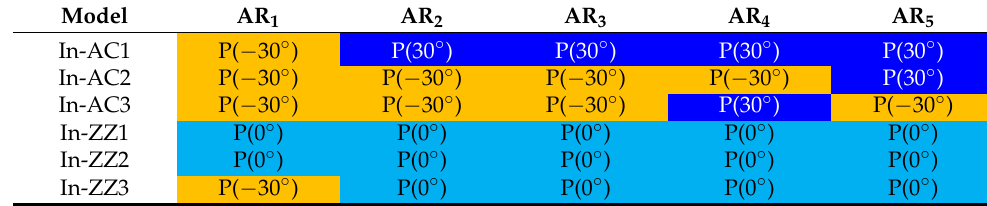
Note that the same crack paths share the same